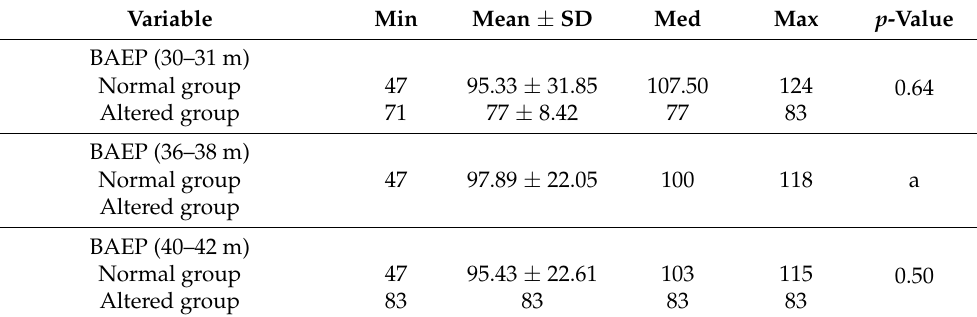
Table 4. Comparison * between the BAEP groups (considering two sides) and Bayley III (composite